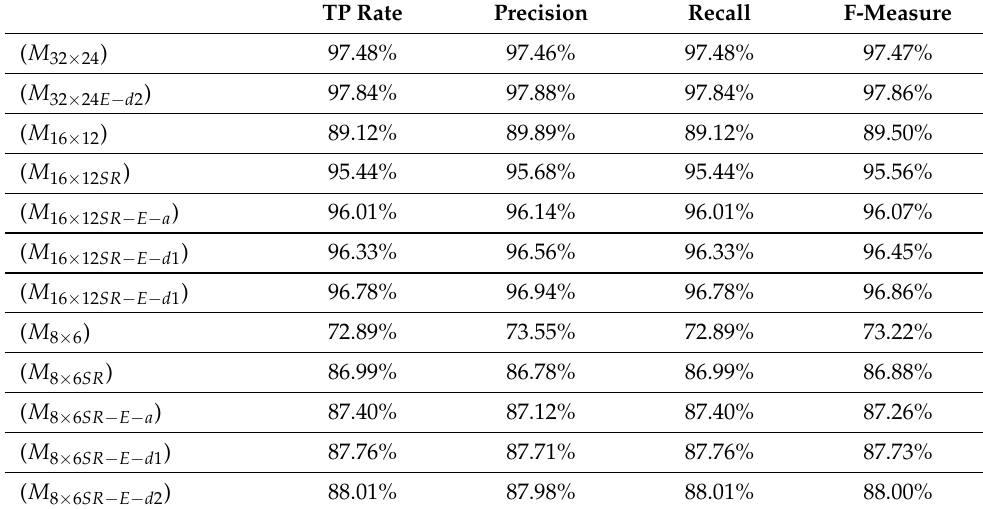
Table 9. The classification TP rate, precision, recall and F1-score during cross-validation. TP Rate Precision Recall F-Measure